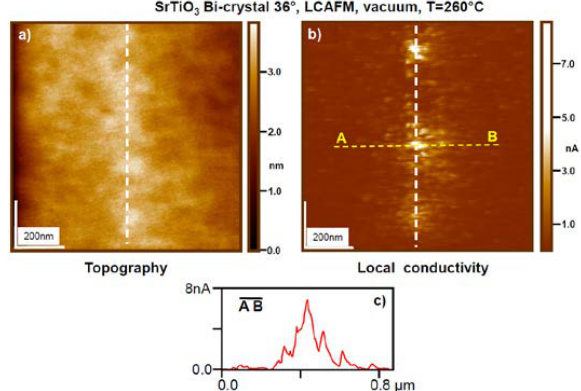
Figure 38. AFM topography ( a ) and LCAFM conducting map ( b ) of the region close to the bicrystalline boundary (36.8°) of stoichiometric SrTiO 3 (100). Cross section ( c ) shows a drastic variation of the local